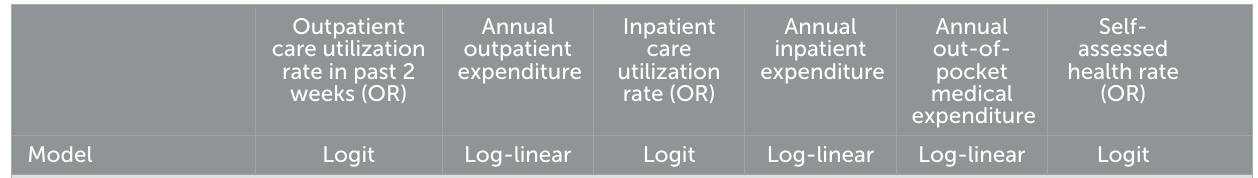
TABLE 5 The results of heterogeneity